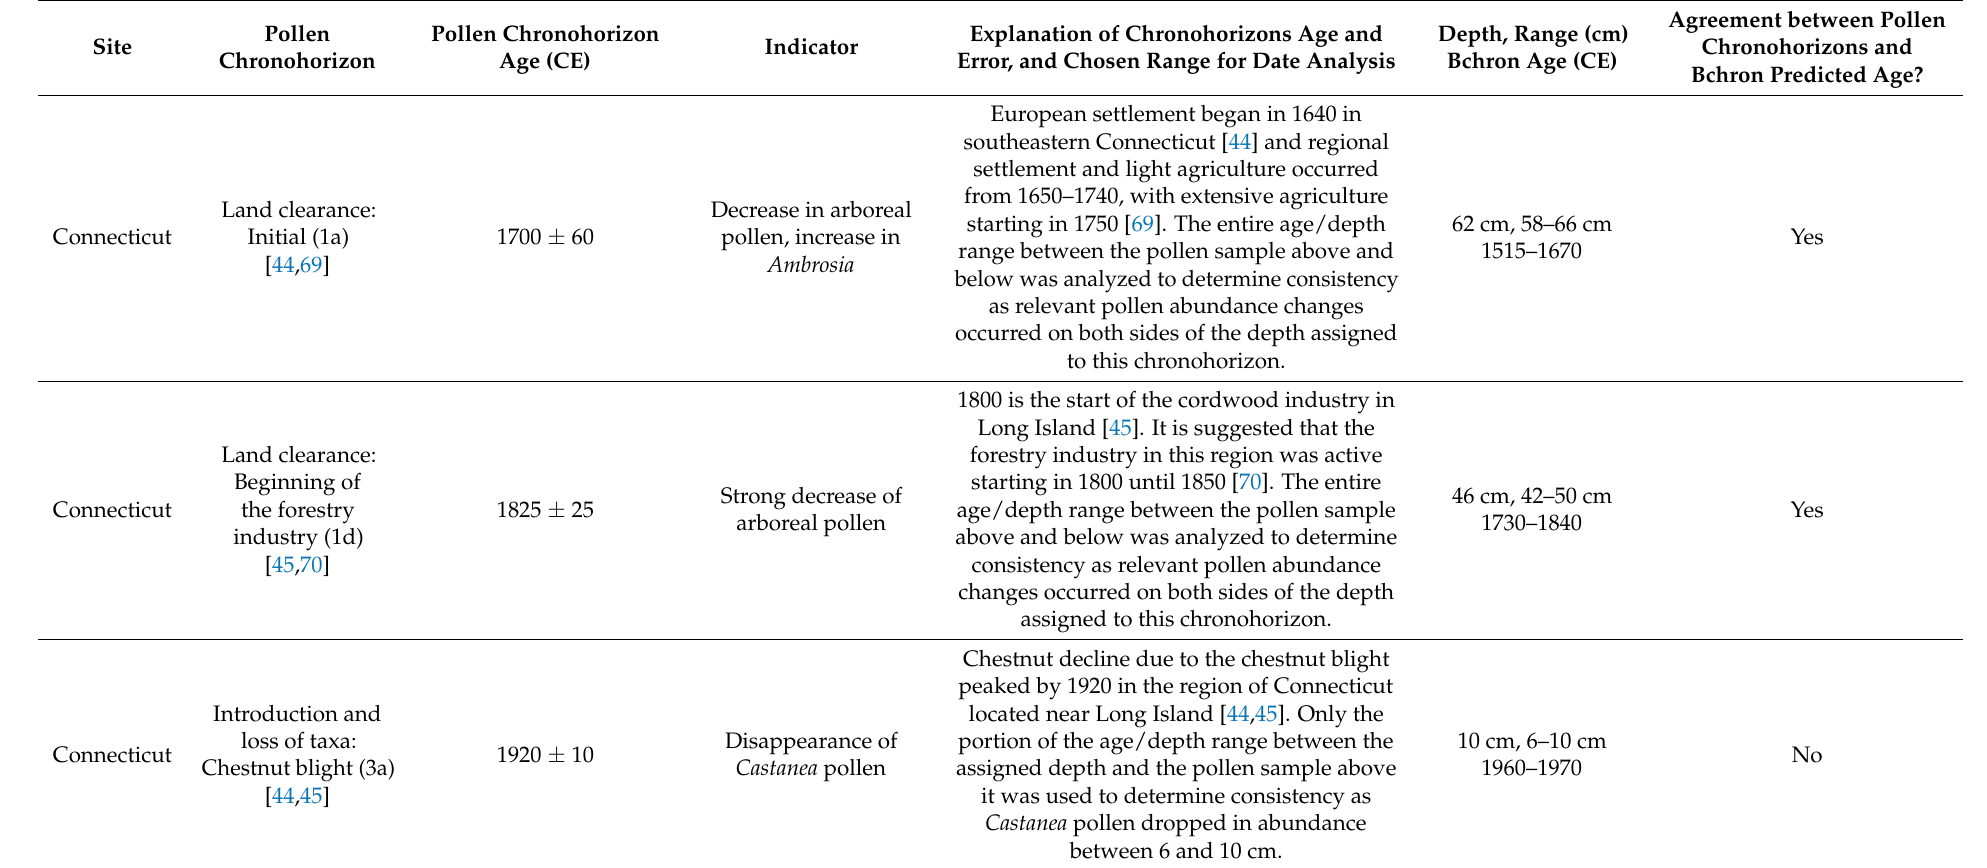
Table 3. Site pollen chronohorizons, their ages, and the ages predicted by NP Bchron model. 1a to 3b refers to the pollen chronohorizon identifier, with the numerical portion of the identifier designating the type of chronohorizon: (1) land clearance; (2) reforestation; and (3) introduction and loss of taxa, and the letter portion designating the specific